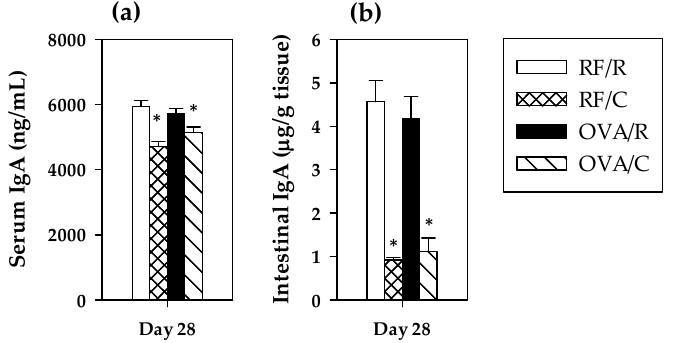
Figure 2. Serum ( a ) and intestinal ( b ) IgA concentrations at the end of the study. Values are expressed as mean ± standard error ( n = 9). Statistical difference: * means statistical significant difference induced by the diet by two ‐ way ANOVA ( p < 0.001). Groups: RF/R = reference group; RF/C = reference group fed cocoa diet; OVA/R = sensitized group; OVA/C = sensitized group fed cocoa diet.